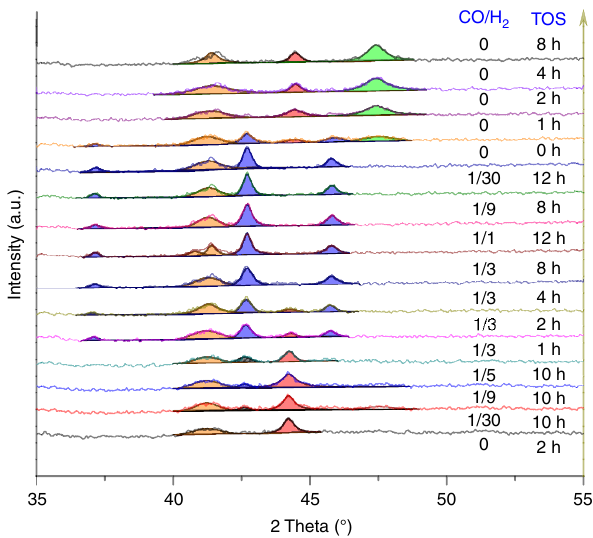
Fig. 3 In situ XRD of a Co 4 Mn 1 K 0 . 1 catalyst. The results refer to a reaction temperature of 220 °C and atmospheric pressure. The same batch of catalyst was sequentially (from low to up) exposed to pure H 2 or syngas (at various p CO /p H2 ) for different times-on-stream (TOS), see also Fig. S5. Red peaks indicate fcc cobalt (111), blue and green peaks are due to Co 2 C and hcp cobalt, respectively. Orange peaks at 2 θ ~41.3° are either Co 2 C (020) or hcp